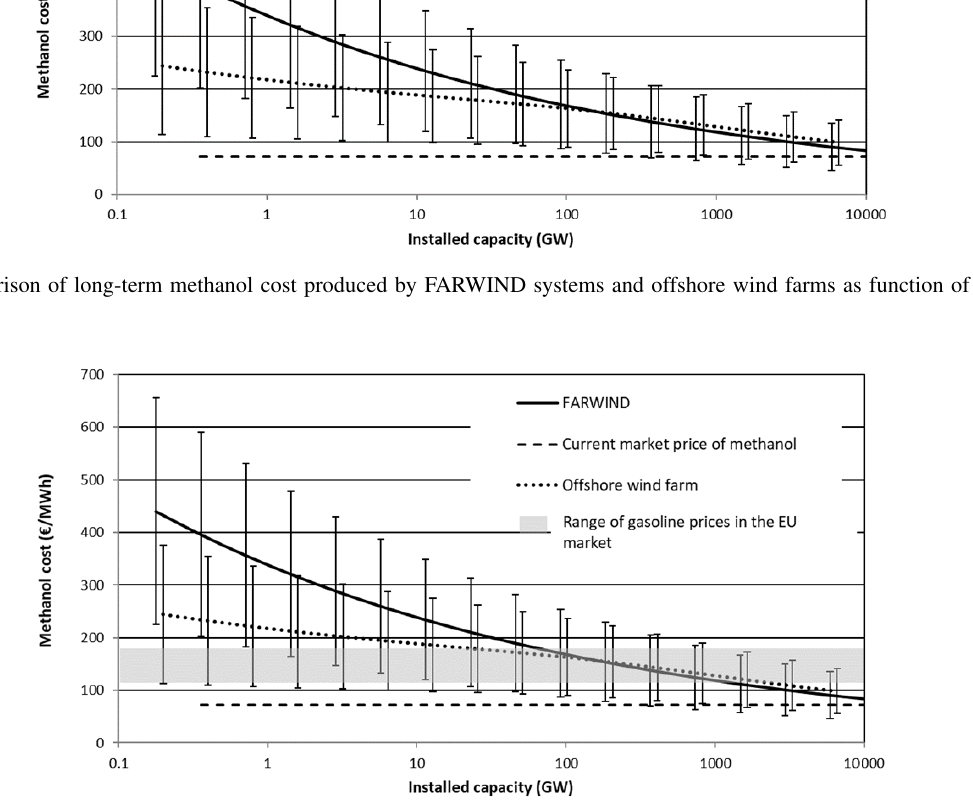
Figure 9. Cost of methanol produced by FARWIND systems and offshore wind farms as a function of the installed capacity and comparison with current market price of gasoline in the